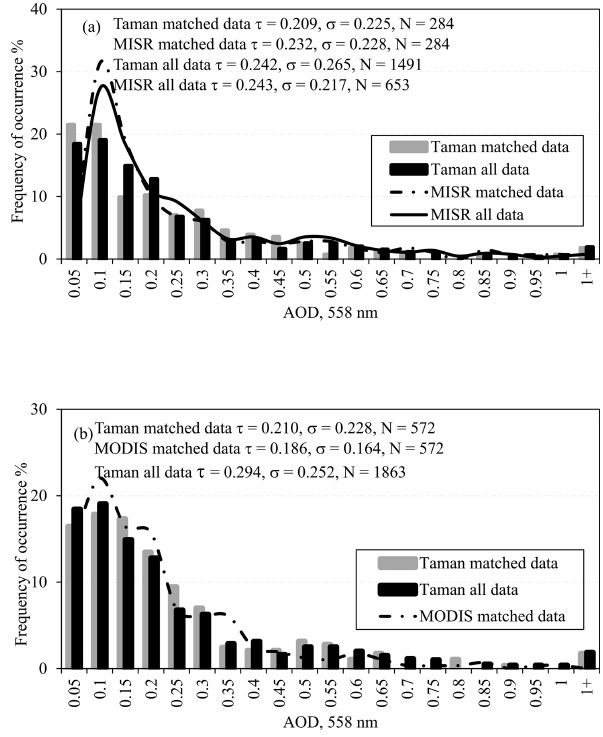
Figure 9. Histogram of the MISR, MODIS, and Saada AERONET measurements (a) MISR and (b) MODIS data retrievals. Figure 10. Histogram of the MISR, MODIS, and Taman